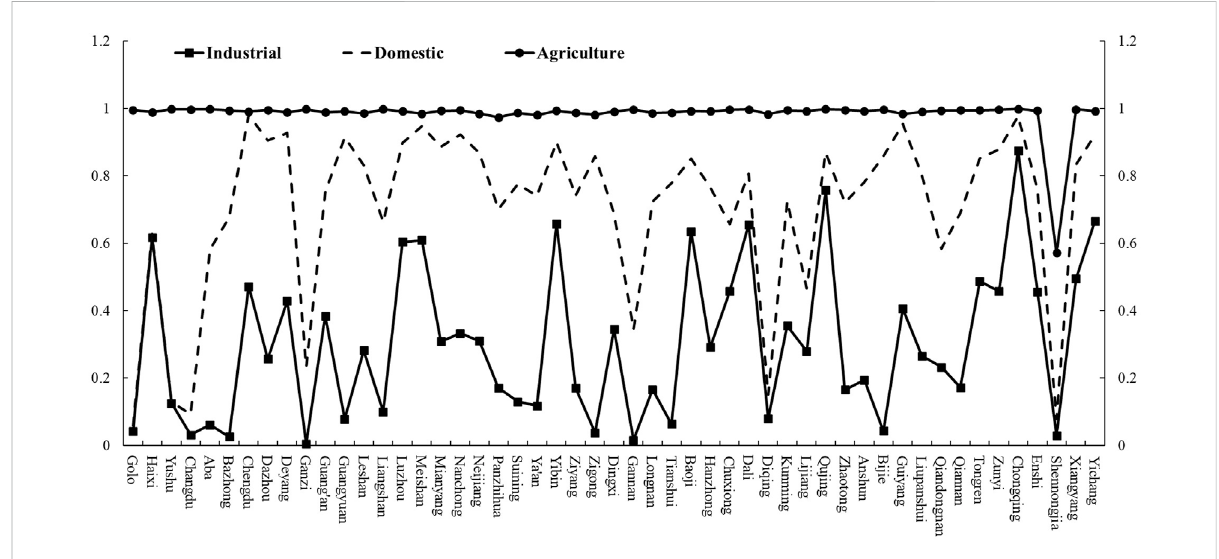
FIGURE 4 Source structure of the upper Yangtze River grey water